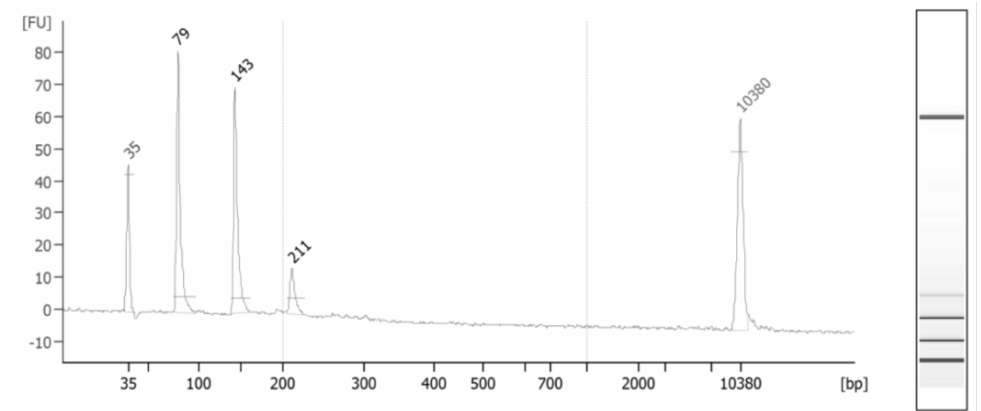
Figure 1. CfDNA fragments extracted from the serum of a randomly-selected ESCC case. The average size is 220 bp, showing several fragments under 200 bp (start and end picks are the standard markers). Long fragments (between 200 and 1000 bp) consisted of 11% of total serum cfDNA.